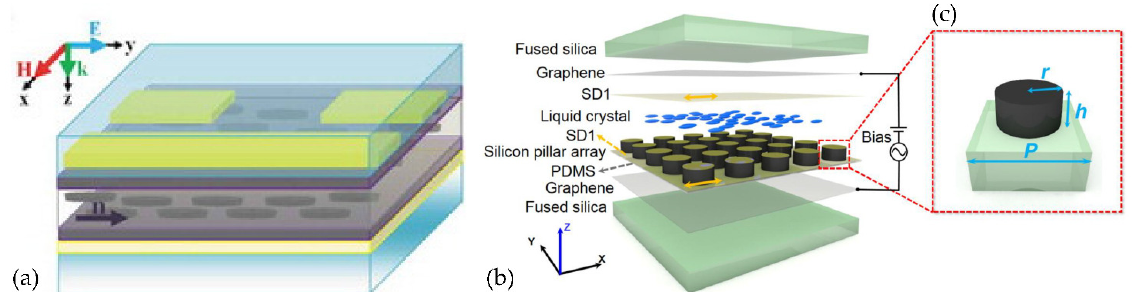
Figure 13. Metamaterial absorber in the THz range: ( a ) Planar Square Titanium SRR [74]. ( b ) The decomposition diagram of the LC-integrated dielectric metamaterial [76]. ( c ) The unit dimension of the pillar resonator: lattice periodicity, p: 210 μm; radius, r: 64 μm; height, h: 60 μm. Reprinted with permission from Ref. [74,76]. 2019 Taylor & Francis and 2018 MDPI.